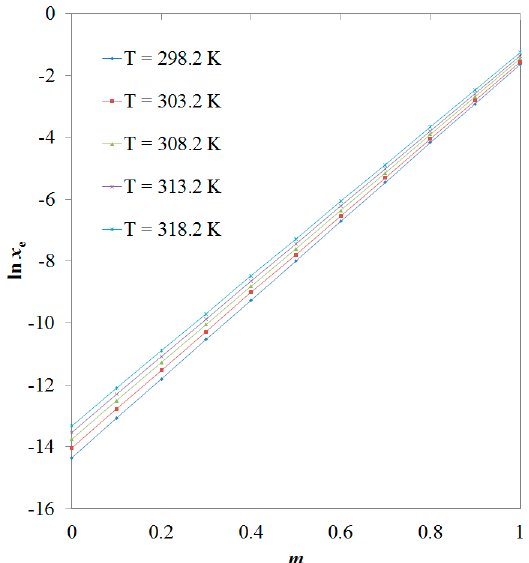
Figure 3. Influence of Carbitol mass fraction ( m ) on FFA logarithmic solubility (ln x e ) at T = 298.2–318.2 K.